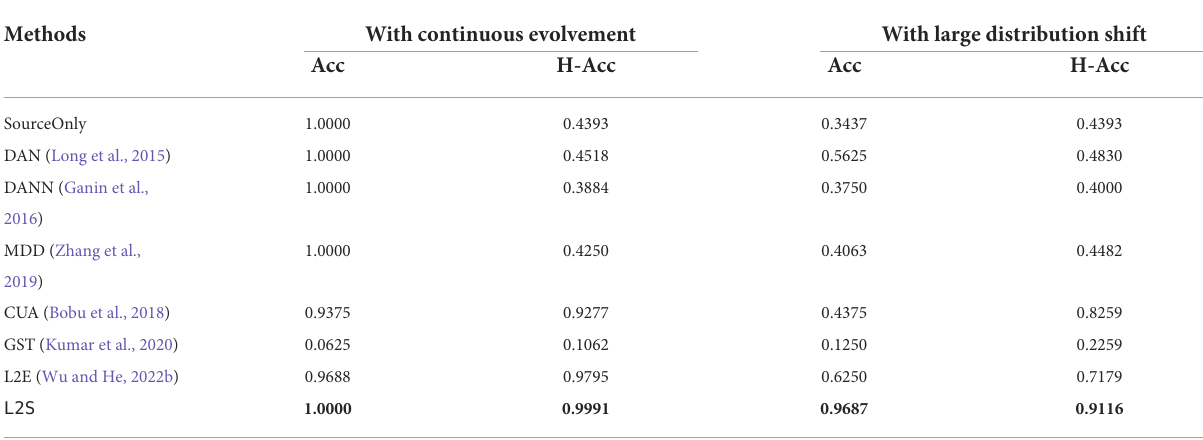
TABLE 1 Results of dynamic transfer learning on Rotating